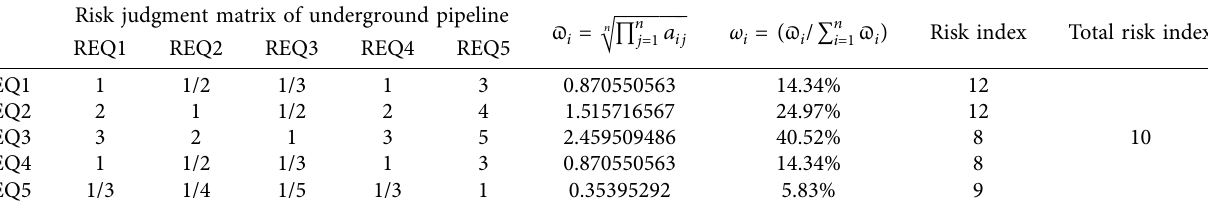
Table 39: Risk judgment matrix of underground pipeline.